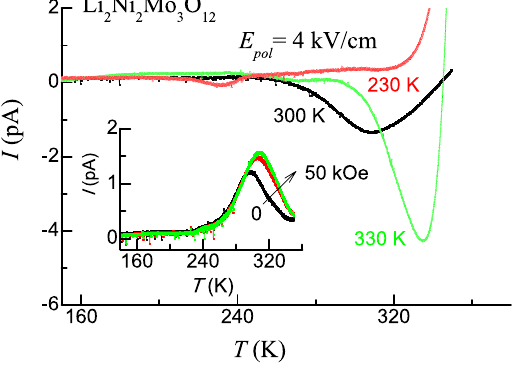
Figure 4. Pyrocurrent behaviour obtained with a poling field of 4 kV/cm for Li 2 Ni 2 Mo 3 O 12 for poling temperatures of 230, 300 and 330 K. Inset shows pyrocurrent behavior in the presence of magnetic fields at 300 K for the poling electric field of − 4kV/cm and an arrow is drawn to show that the curves move towards higher temperature range with increasing magnetic field with the curves corresponding to 0, 30 and 50 kOe.